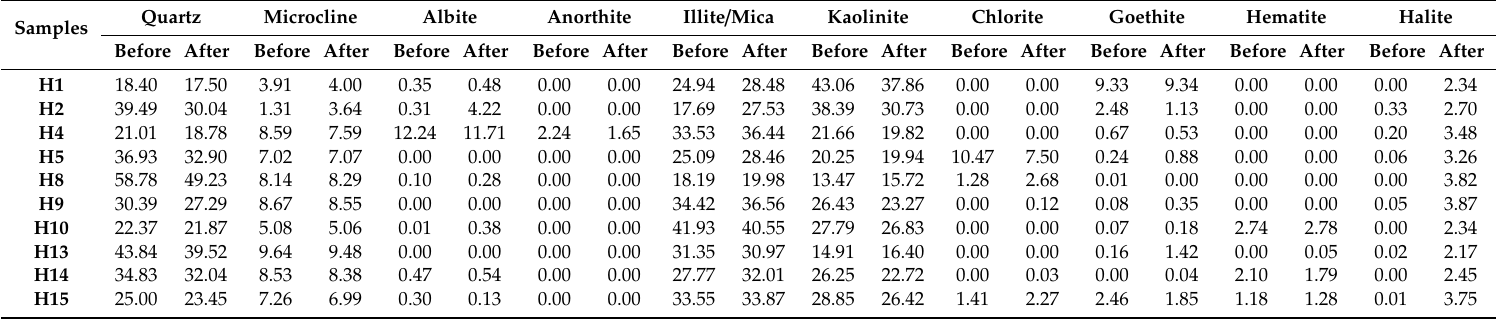
Table 1. XRD semi-quantitative mineralogy for Harvey3 seal rocks in weight%, before and after exposure.